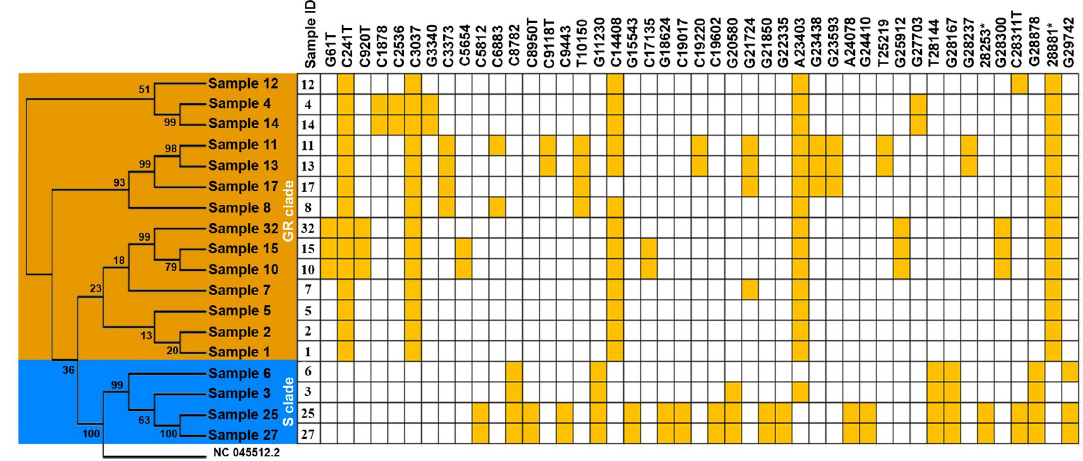
Fig 1. The Uzbek SARS-CoV-2 sequences clustered into 2 clades. A phylogenetic tree was generated in MEGA X based on the 18 viral sequences of severe acute respiratory syndrome coronavirus 2 (SARS-CoV-2) in samples collected from COVID-19 patients in the Tashkent region using the maximum likelihood method. This maximum likelihood tree was rooted by the Wuhan reference strain NC_045512.2 and produced using 128 mutations discovered in the 18 sequences (see S1 Table). The distribution of mutations shared by two or more sequences. A CA ! TC substitution is located at position 28253 � , and a GGG ! AAC substitution is at 28881 �� . Bootstrap values are shown.